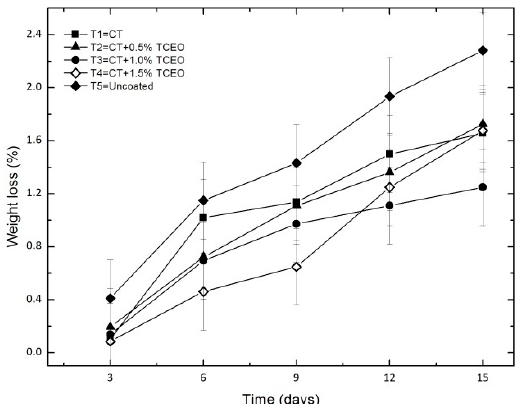
Figure 6. Evolution of weight loss percentage in strawberries with chitosan (CT) and treatments of oil (TCEO): T1 = CT, T2 = CT + 0.5% of TCEO, T3 = CT + 1.0% of TCEO, T4 = CT + 1.5% TCEO, and T5 = uncoated. Mean values and intervals of Fisher’s LSD of 95% according to the ANOVA test.